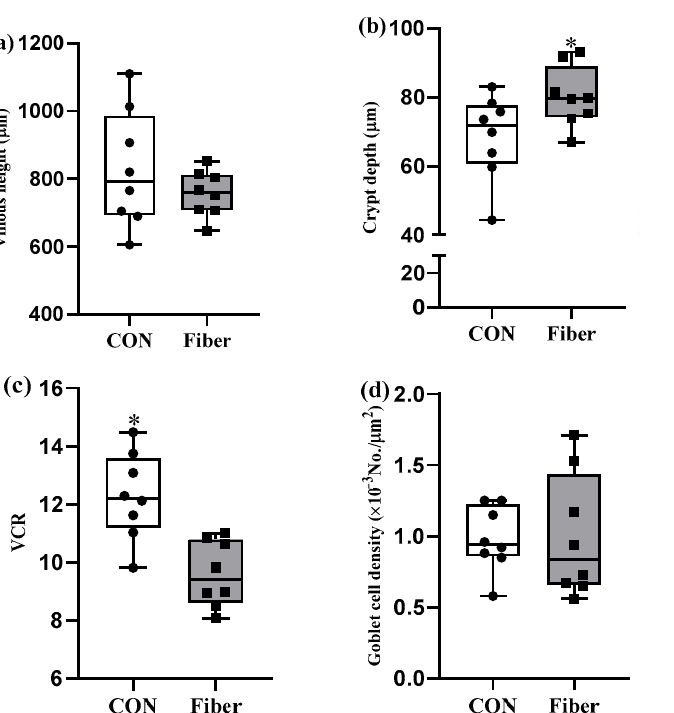
Figure 2. The effects of maternal fiber intake on ileal histomorphology and number of goblet cells of newborn piglets. ( a ), Villous height; ( b ), Crypt depth; ( c ), Ratio of villous height to crypt depth (VCR); ( d ), Goblet cell density of newborn piglets. Values are presented as box-and-whisker plots, * means p < 0.05.